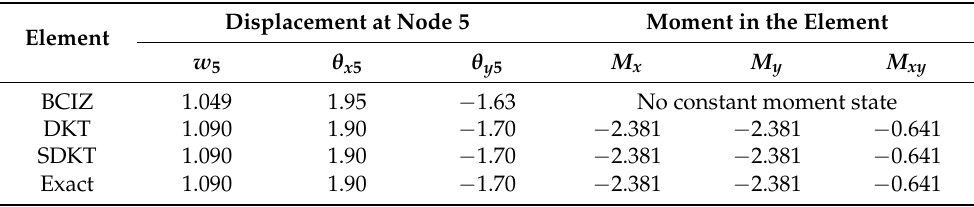
Table 1. Patch test results of the different plate elements.